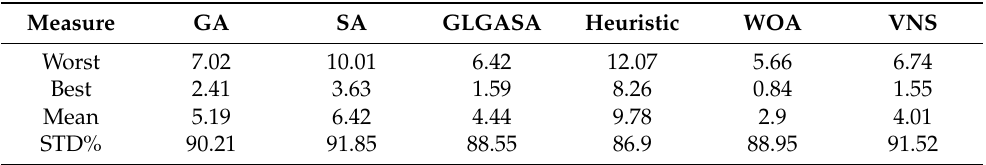
Figure 10. Comparison of the worst, mean, and best results, obtained by different methods. Table 18. Improvement rate (%) of the H-WOA-VNS algorithm against other algorithms, in terms of the worst, best, mean, and STD% of the obtained OF over 10